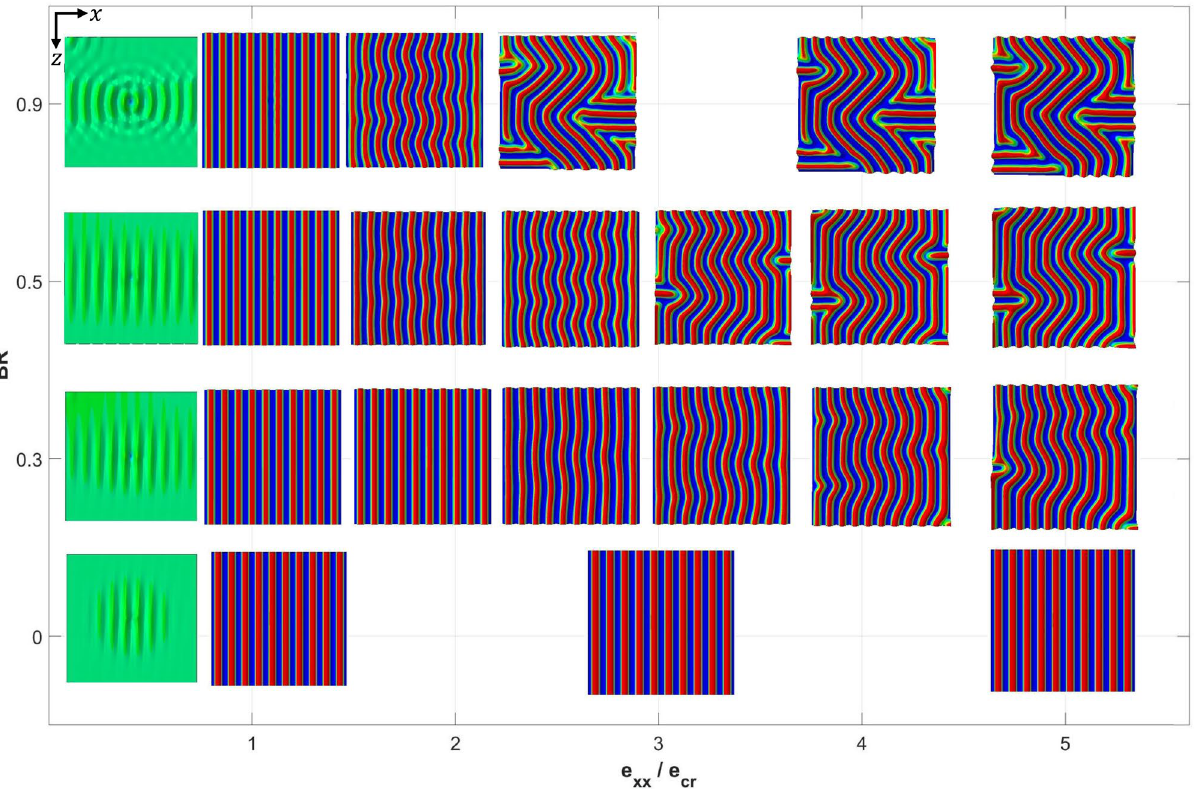
Figure 5. Evolution of wrinkling patterns as a function of applied strain (normalized by the critical value) and biaxiality ratios within the range of 0